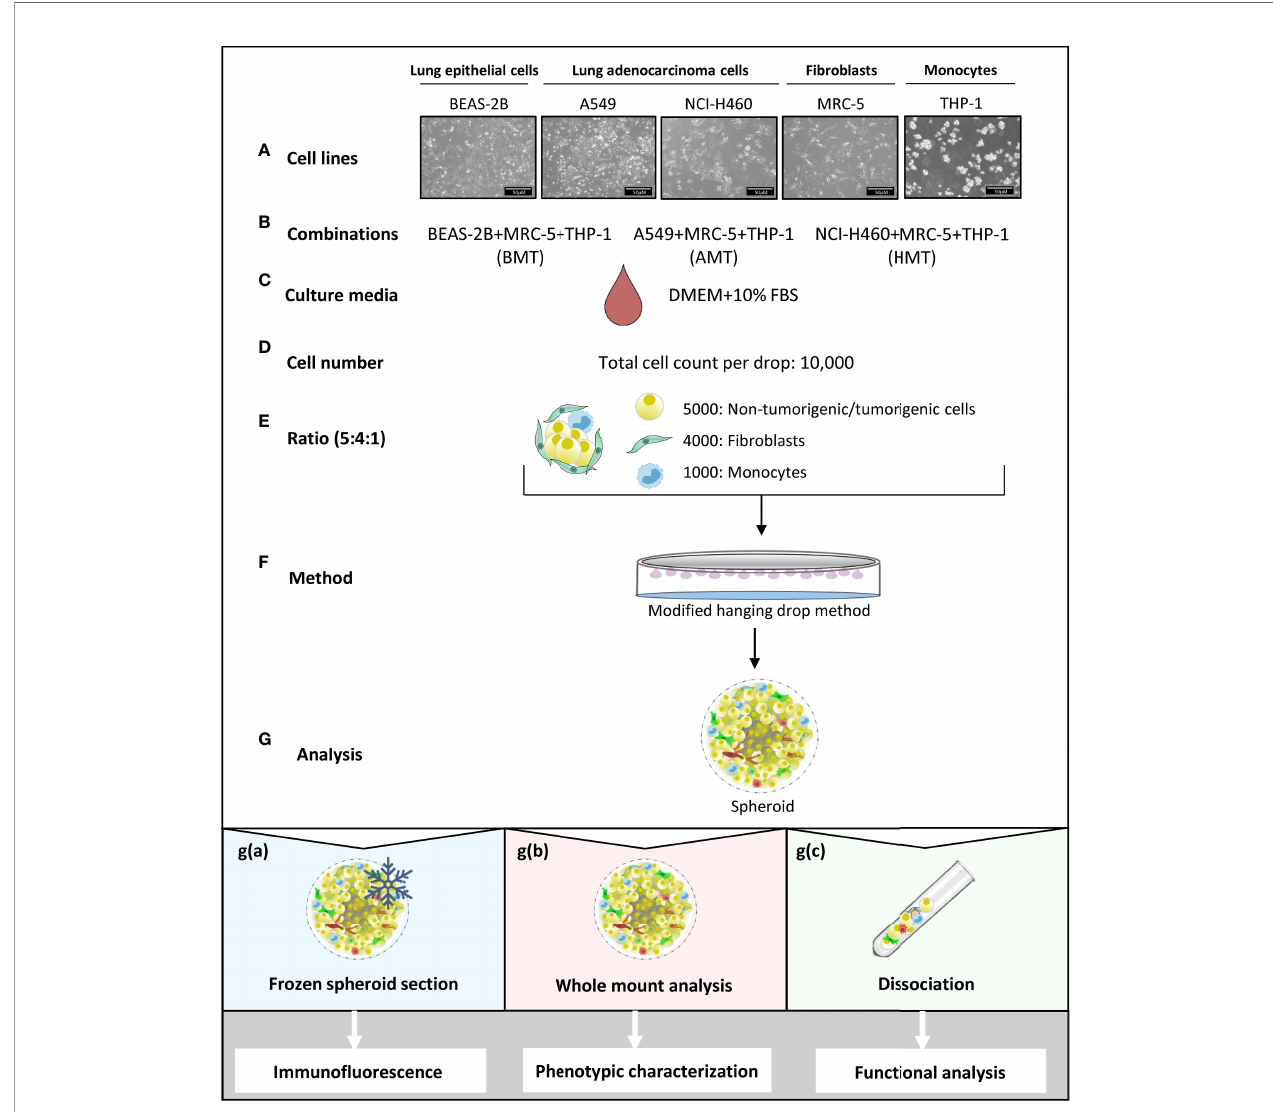
FIGURE 1 | Schematic representation of multicellular 3D spheroid development protocol and their use in different experimental analysis. (A – F) Normal lung epithelial cells (BEAS-2B), lung adenocarcinoma cells (A549 and NCI-H460), MRC-5 fi broblasts, and THP-1 monocytes are used to prepare multicellular tumor spheroids (BMT, AMT, and HMT) in DMEM+10% FBS growth medium. After optimization, as detailed in the result section, 10,000 cells per 25 m l drop in a ratio of 5:4:1 (BEAS- 2B/A549/NCI-H460: MRC-5: THP-1) are taken to prepare spheroids using hanging drop method. (G) Different techniques are used for spheroid